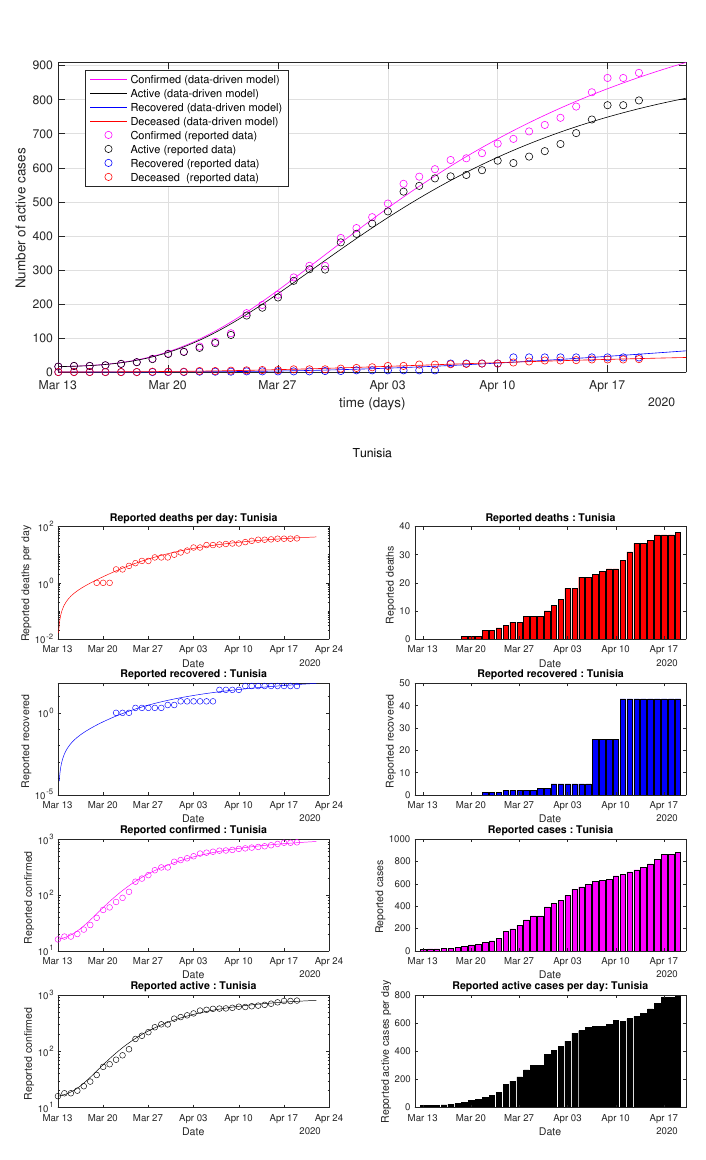
Figure 87. Tunisia: data vs.